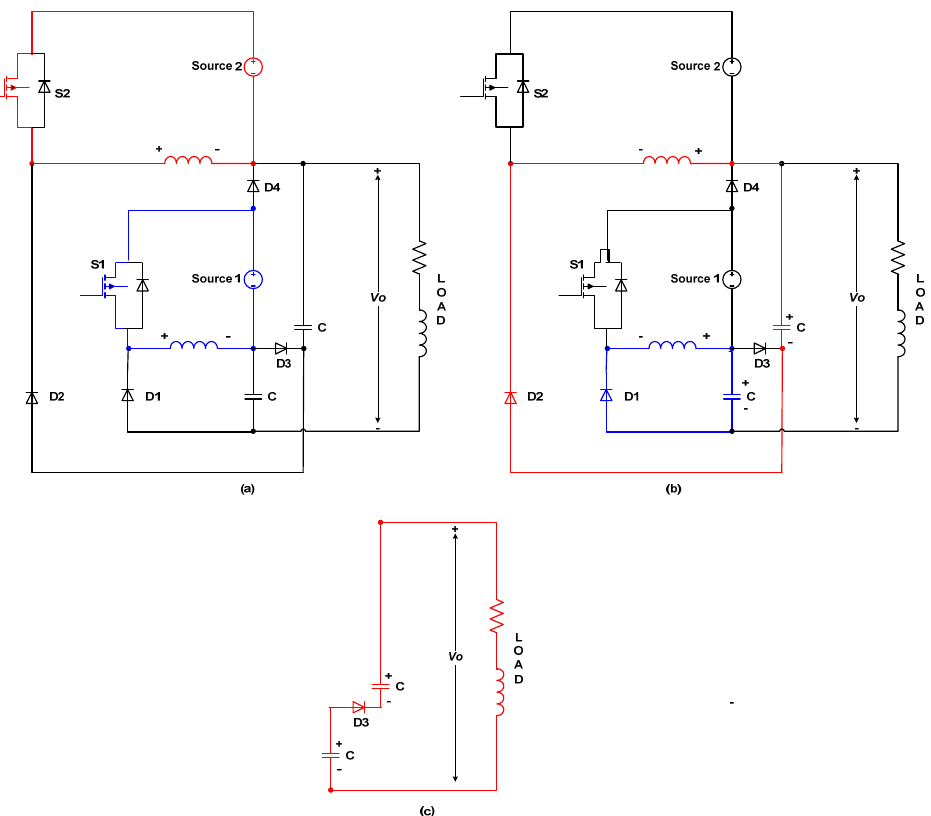
Figure 1. Suggested buck-boost DC–DC converter.